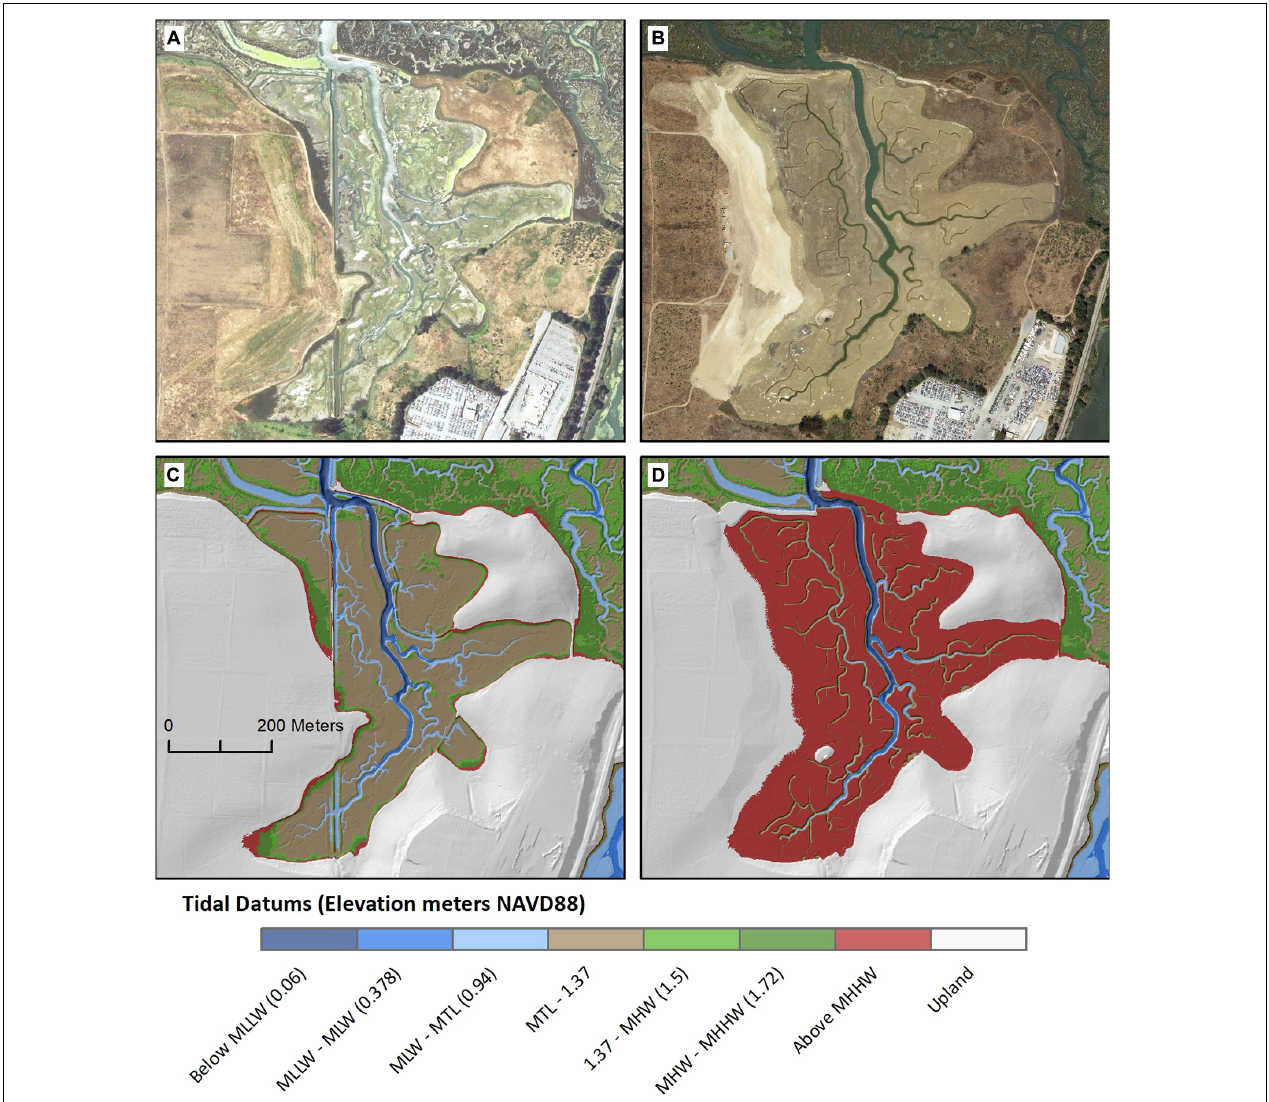
FIGURE 4 | UAV-collected orthomosaics of Hester Marsh showing (A) the degraded marsh prior to construction in 2015, and (B) the initially bare marsh after construction was completed in 2018. UAV DEMs showing the change between (C) pre-construction elevation in 2015, and (D) post-construction elevation in